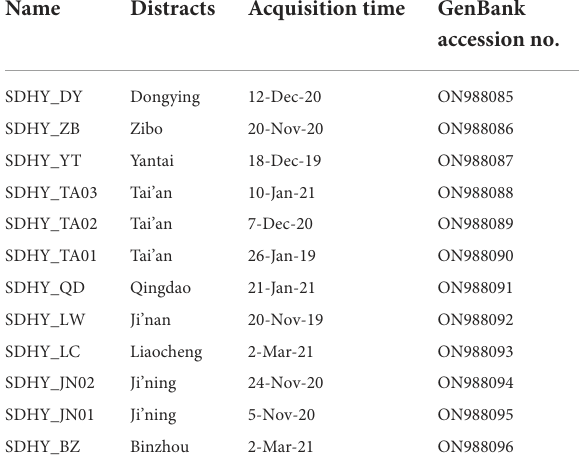
TABLE 3 Information of PEDV positive